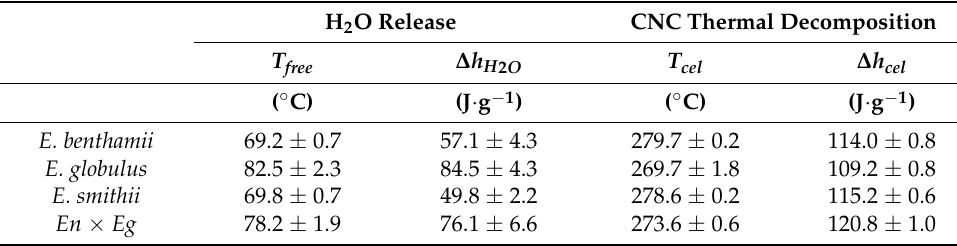
Figure 4. Stacked calorimetric thermograms of the CNCs obtained from the different eucalyptus species. Table 4. Peak temperatures and enthalpies for the water release ( T H 2 O and ∆ h H 2 O ) and CNC thermal decomposition ( T cel and ∆ h cel ), as obtained from the calorimetric